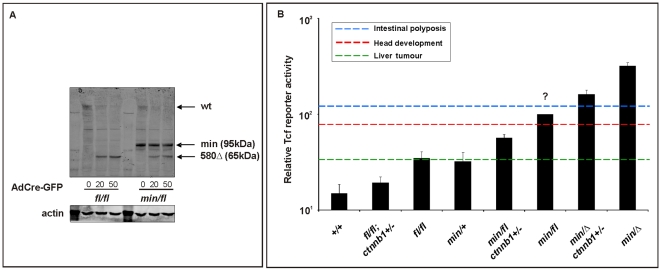

In vitro assessment of Wnt signaling in MEFs from Apc hypomorphic mice.(A) Western blot analysis of MEF cell lysates, prepared from (fl/fl) and (min/fl) mice, 48 h after infection with Cre-GFP expressing adenovirus (AdCre-GFP) at different concentrations. Note the gradual reduction of full-length Apc protein (wt) with increasing amount of AdCre-GFP administration and simultaneous accumulation of the truncated Apc580Δ protein encoded by the recombined Apcfl allele. The truncated Apc protein encoded by the Apcmin allele is indicated (min). (B) Tcf4 reporter activity in MEFs of the indicated genotype in response to a submaximally active concentration of Wnt3a-conditioned medium. Activity was assessed following transient transfection with pSuperTopFlash. Cells were harvested 48 h later and assayed for luciferase activity using the dual luciferase system. The activity of the Tcf4 reporter in (min/fl) MEF exposed to a submaximal Wnt3a stimulation was arbitrarily set to 100 and analysis was performed in triplicate cultures. Horizontal lines indicate the signaling threshold predicted for the indicated phenotypes to occur in mice of the corresponding genotypes. The question mark refers to the position of the “intestinal threshold” line relative to reporter activity in min/fl MEFs, since the corresponding adult min/fl mice can not be generated. At least two independent experiments were performed in triplicates for each genotype. Mean ± SD. Note: Histograms refer to situation before LOH, intestinal polyposis threshold to situation after LOH, where applicable. Genotypes are as follows: wild-type (+/+); Apcmin/+ (min/+); Apcfl/fl (fl/fl); Apcmin/fl (min/fl); Apcmin/Δ580 (min/Δ); Apcfl/fl;Ctnnb1+/− (fl/fl;ctnnb1+/−); Apcmin/fl;Ctnnb1+/− (min/fl;ctnnb1+/−); Apcmin/Δ580;Ctnnb1+/− (min/Δ;ctnnb1+/−). All MEFs were derived from mice on a mixed genetic 129Sv x C57BL/6 background.